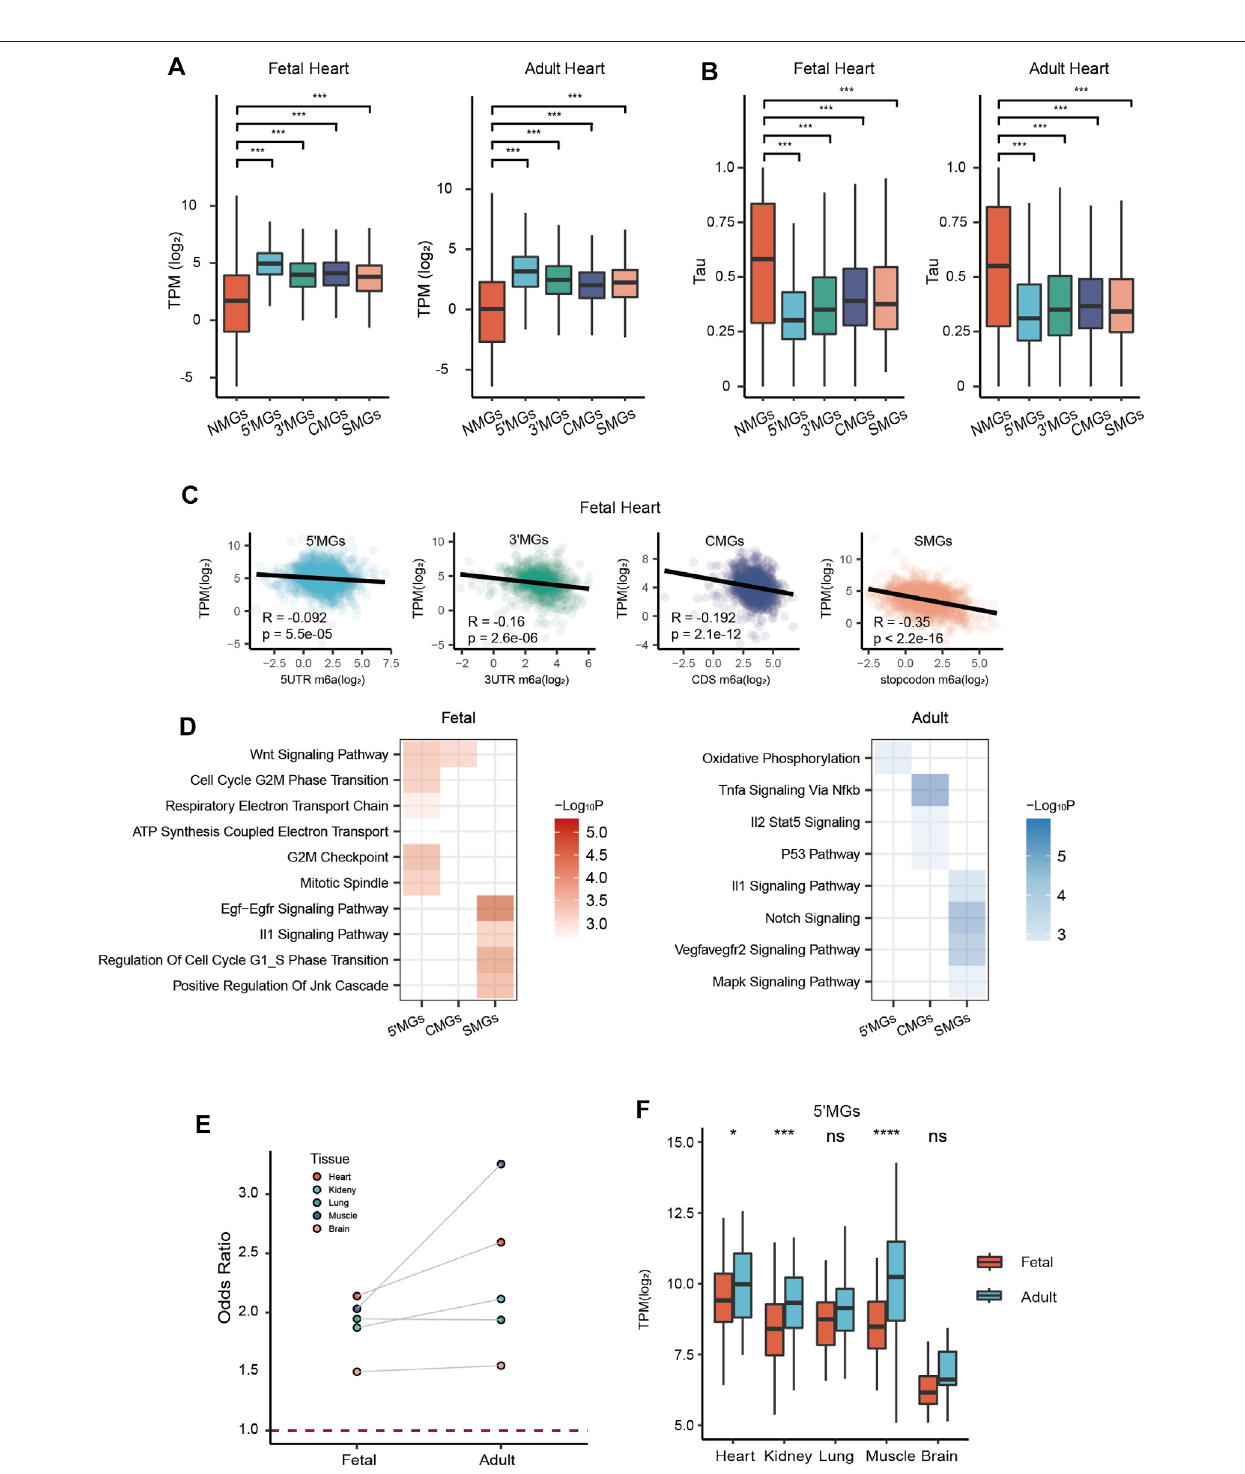
FIGURE 2 | Functional characterization of gene groups with different m6A topologies. (A) The expression level (transcripts per kilobase per million mapped reads, TPM) of fi ve group genes in fetal and adult heart tissue (ANOVA, *** p value < 0.001). (B) The tissue speci fi city score tau of fi ve gene groups in fetal and adult heart tissue (Kruskal – Wallis rank-sum test, *** p value < 0.001). (C) Scatter plots showed the correlation analysis between expression level and m6A methylation at different genic regions, including 5 ′ UTRs, 3 ′ UTRs, CDS, and around stop codon (100 nucleotides upstream and 100 nucleotides downstream of the stop codon) in fetal heart tissue. (D) Heatmap showing function enrichment analysis of each group genes across all tissues in fetal (Left) and adult (Right) stages. Color key from white to red indicates − Log 10P in fetal tissues and from white to blue indicates − Log 10P in adult tissues. (E) The odds ratio of 5 ′ MGs which belonged to the energy metabolism associated GO term genes across all tissues in fetal and adult stages. (F) The expression level of energy metabolism associated 5 ′ MGs across all human tissues in fetal and adult stages (Student ’ s t -test, *** p value < 0.001, * p value < 0.05, ns: not signi fi cantly).